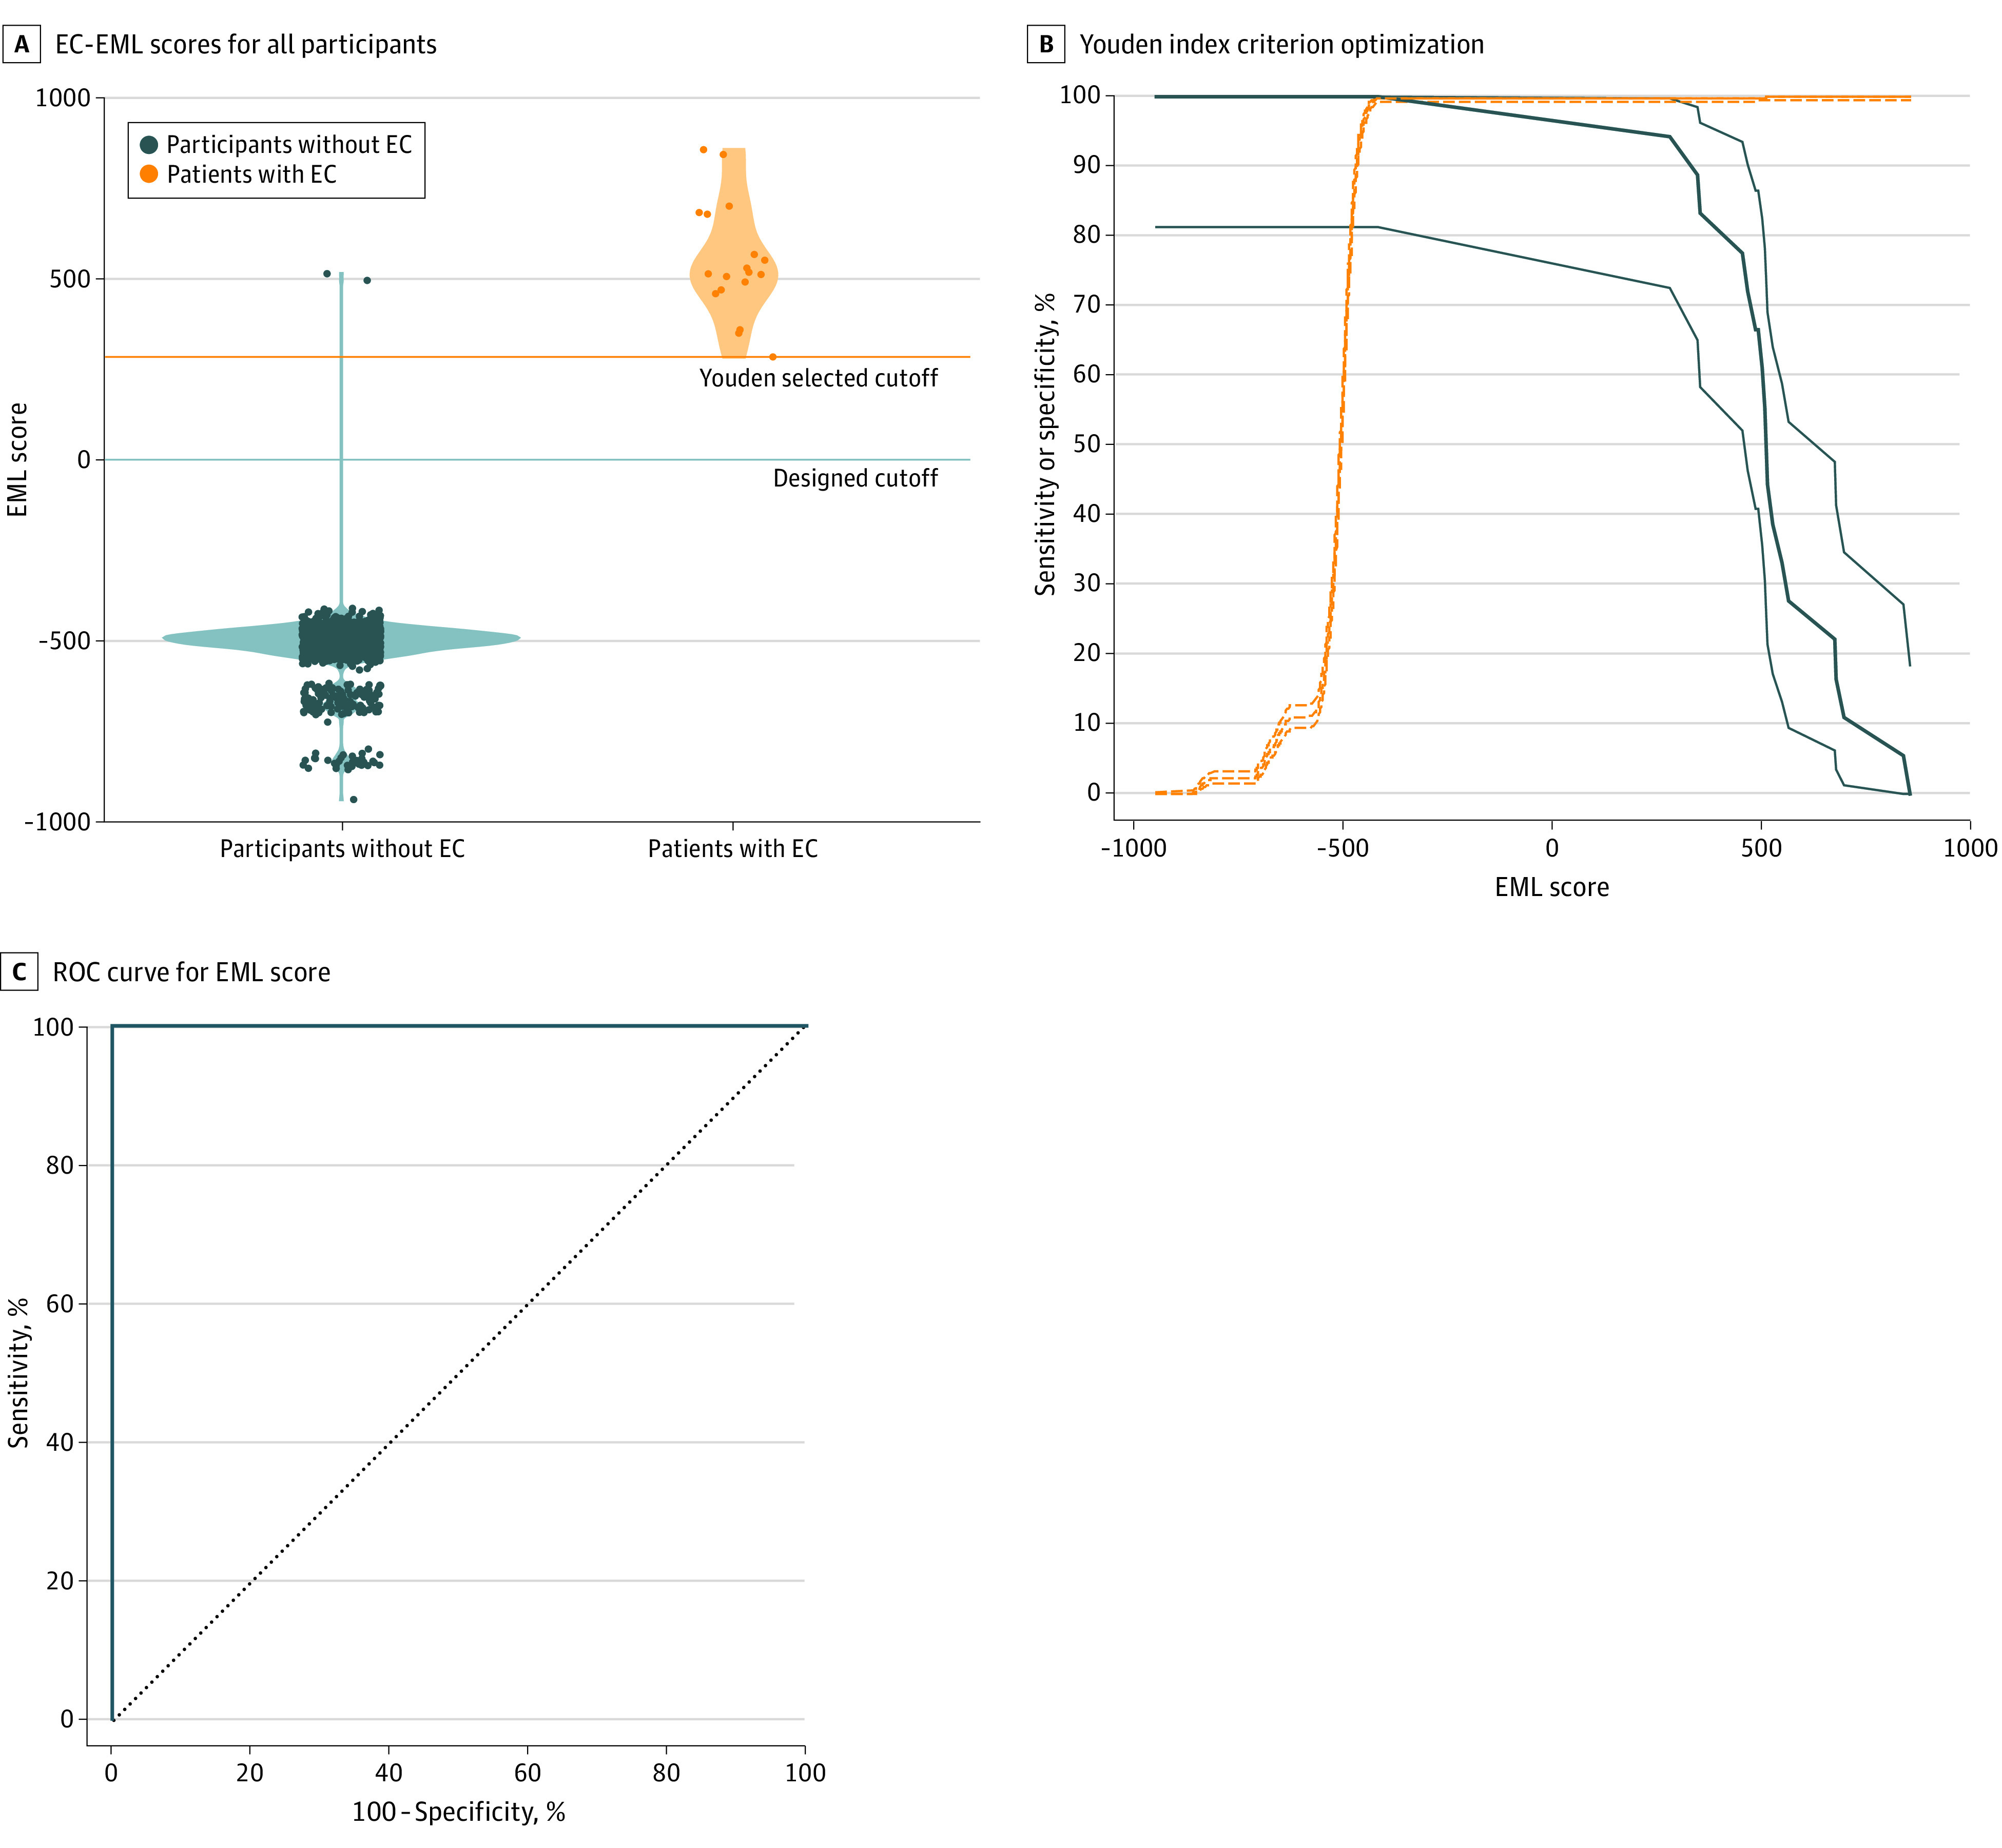
Endometrial Cancer Ensemble Machine Learning (EC-EML) ScoreA, Circles represent EC-EML scores. The orange line represents the cutoff value evaluated by Youden index optimization, while the blue line represents EC-EML score of 0, which was the projected cutoff. B, The dotted lines represent the sensitivity while the continuous lines represent the specificity. C, Receiver operating characteristic (ROC) curve of the EC-EML score.